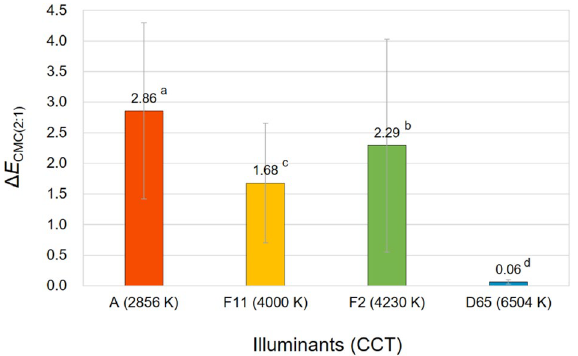
Figure 10. Effect of the correlated color temperature (CCT) of illuminants on the overall color appearance change, Δ E CMC(2:1) , of samples.